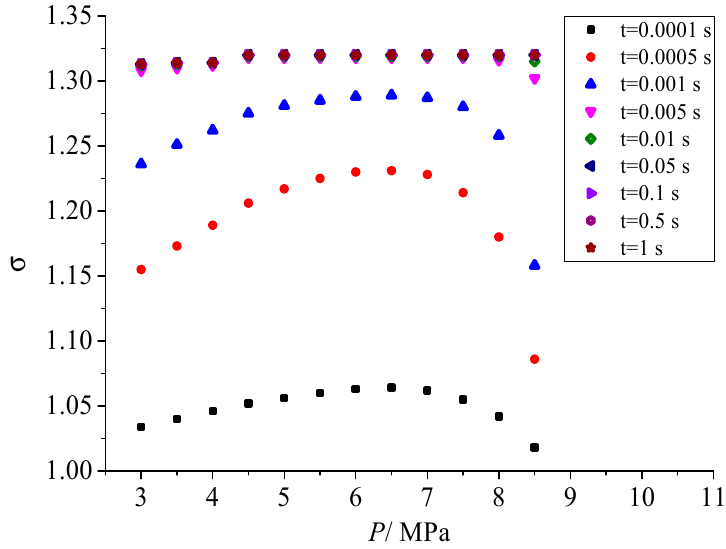
Figure 11. Effect of pressure on geometric standard deviation.